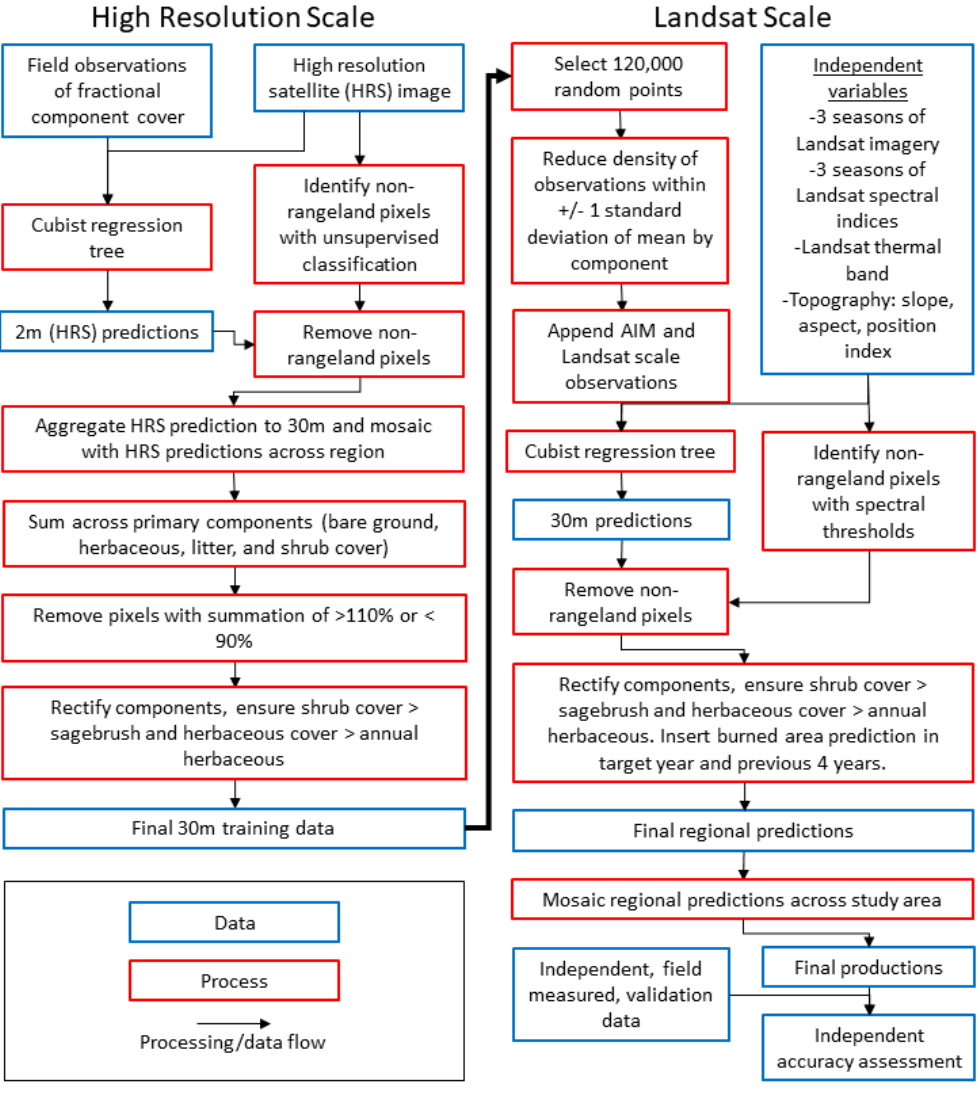
Figure 2. Overview of major processing steps and data inputs for characterization of rangeland fractional component cover.